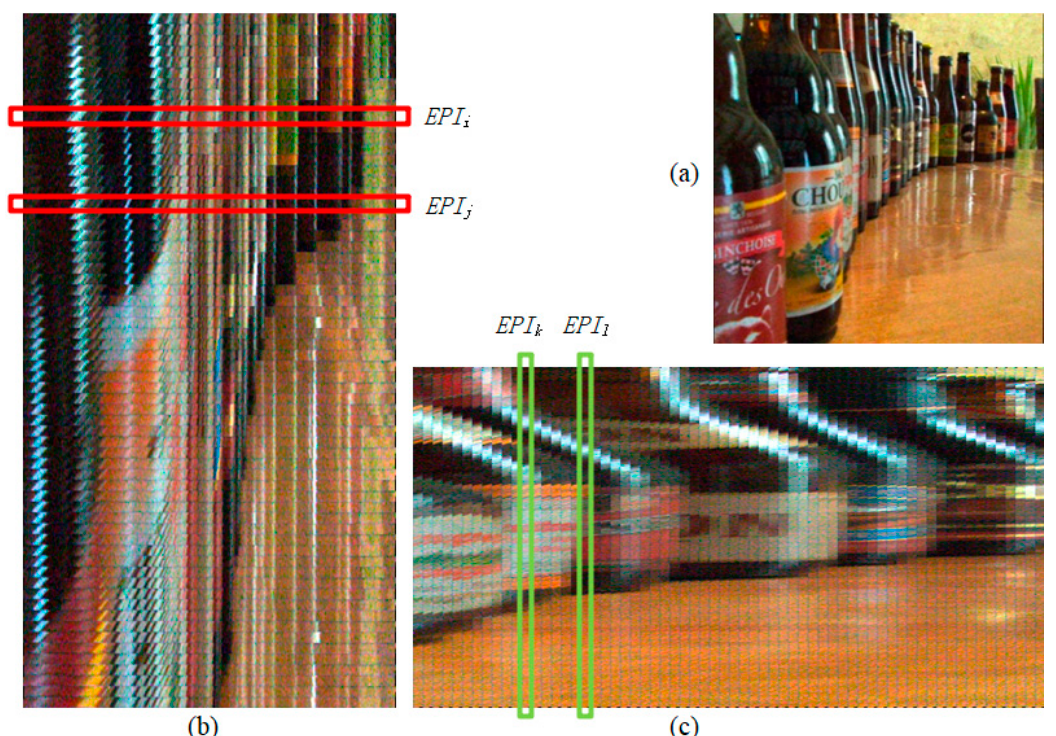
Figure 3. Examples of input images. ( a ) is a central view, ( b ) is a horizontal EPI synthetic image, ( c ) is a vertical EPI synthetic image.